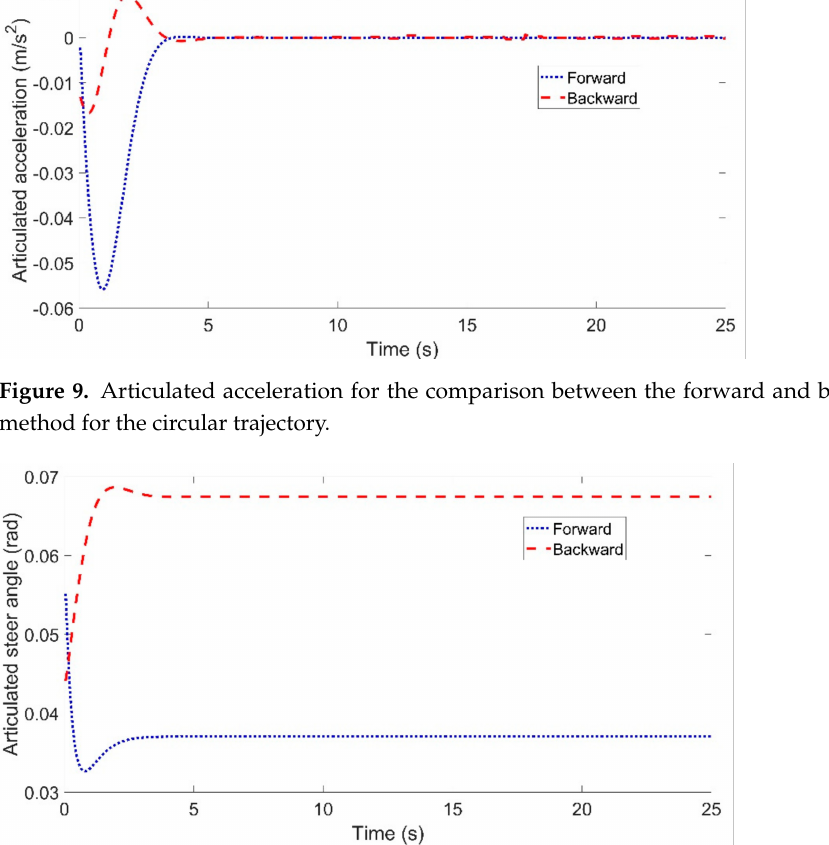
Figure 10. Articulated steer angle for the comparison between the forward and backward Euler method for the circular